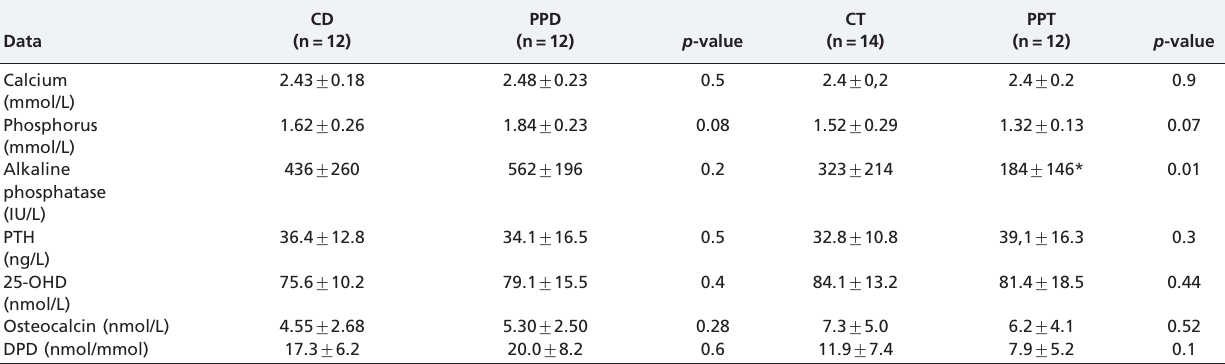
Table 2 - Biochemical evaluation of control groups (CD and CT) and of patients with idiopathic precocious central puberty (iCPP) at the time of diagnosis (PPD) and after treatment with GnRHa